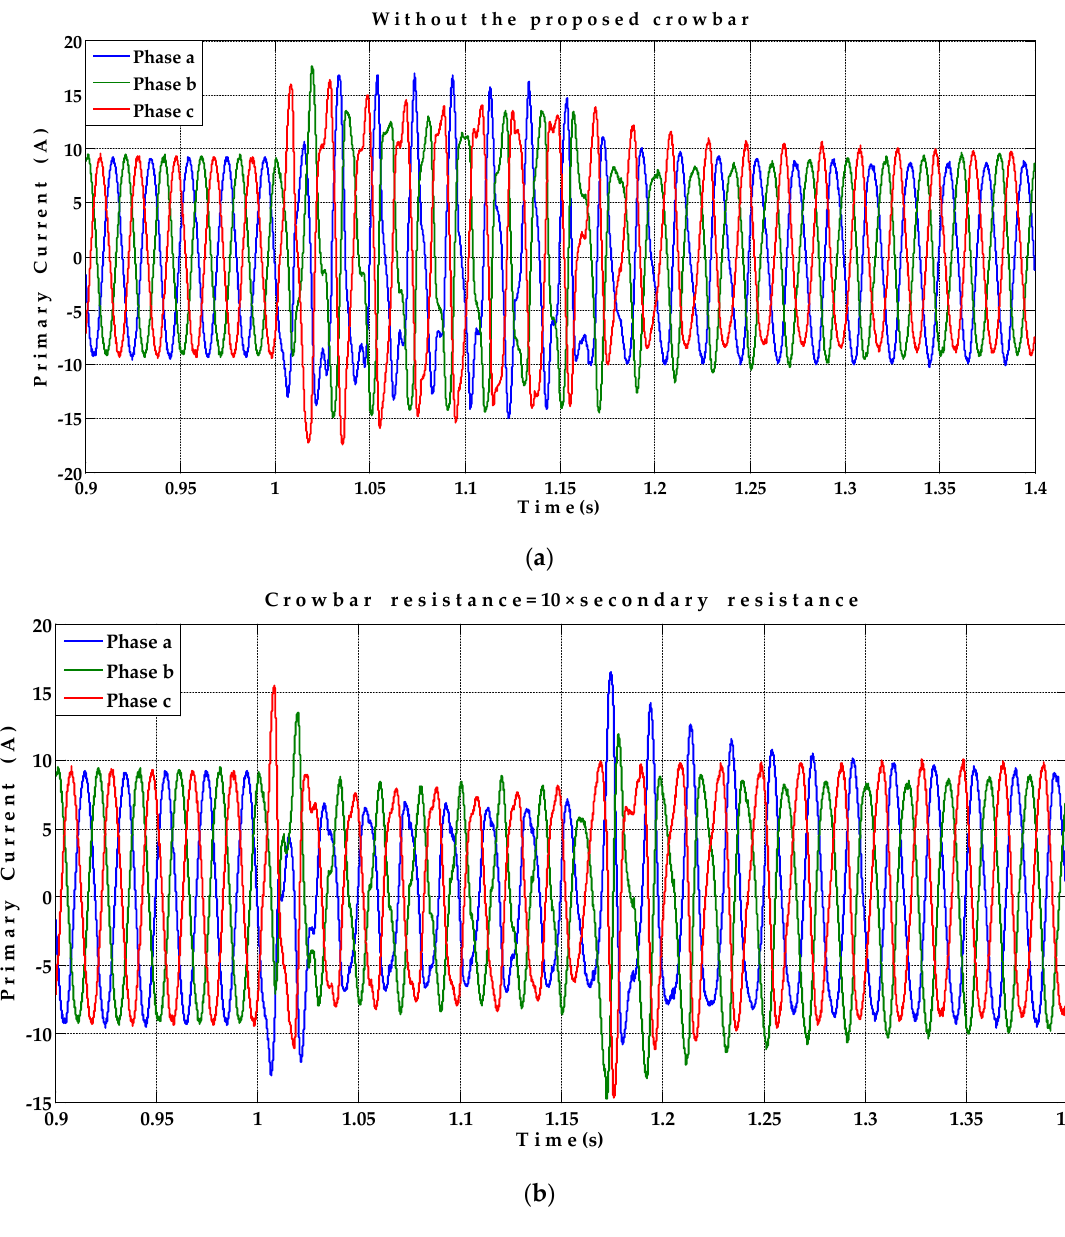
original value (1